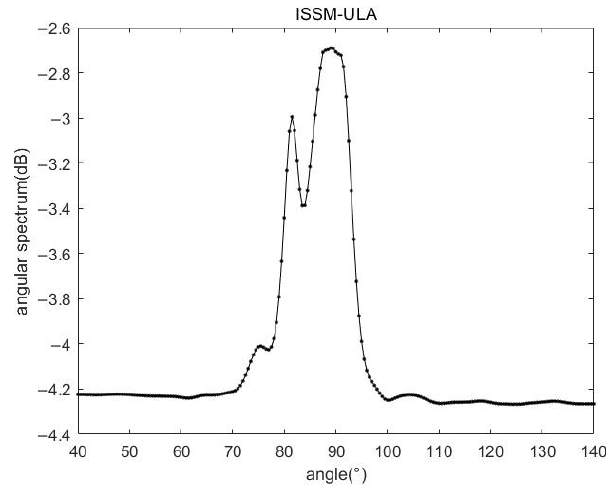
Figure 8. Detection effect based on incoherent signal subspace method.